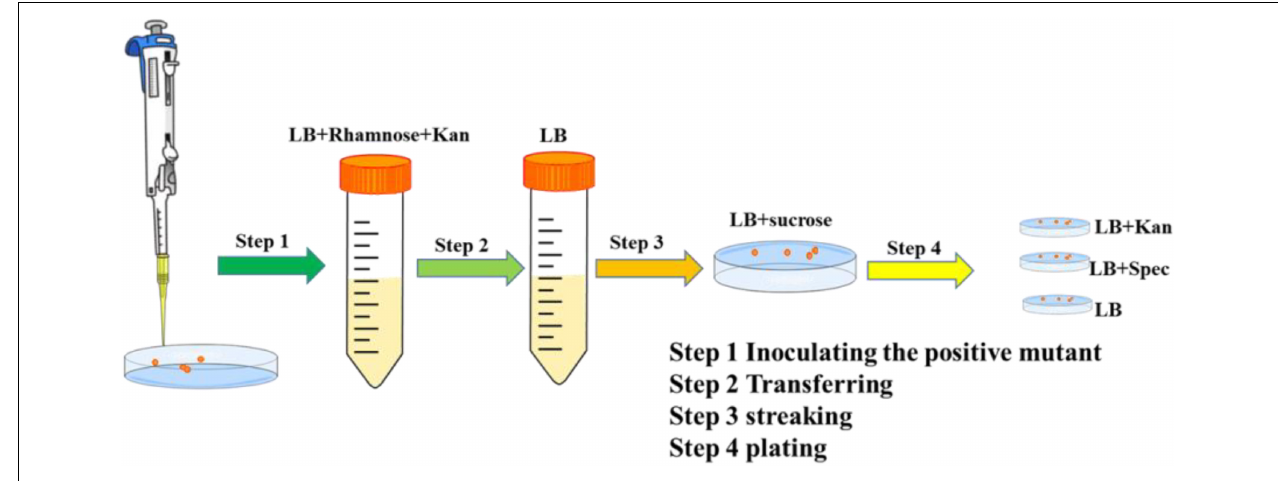
FIGURE 1 | Elimination of the pEcgRNA and pEcCas